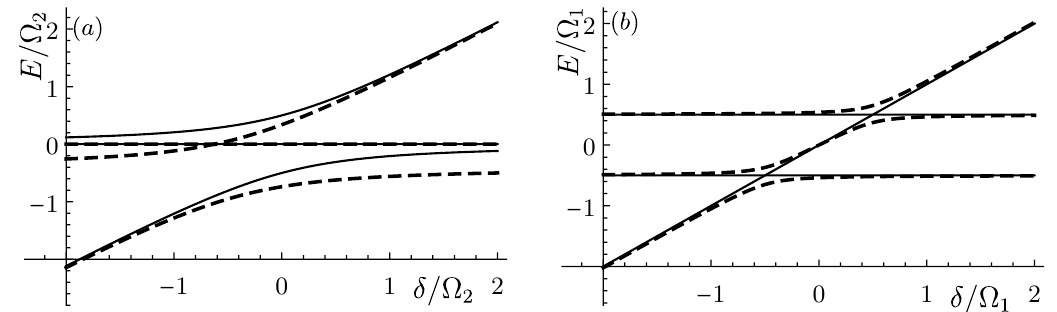
( k ) , Ω ( k ) 1 2 ( k ) = 0, ∆ ( k ) = 0.4 Ω ( k ) 1 2